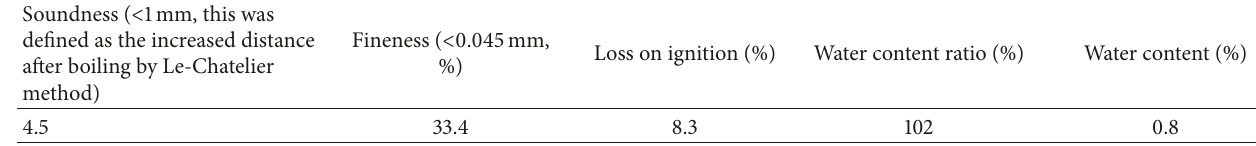
Table 6: Physical parameters of fly ash.